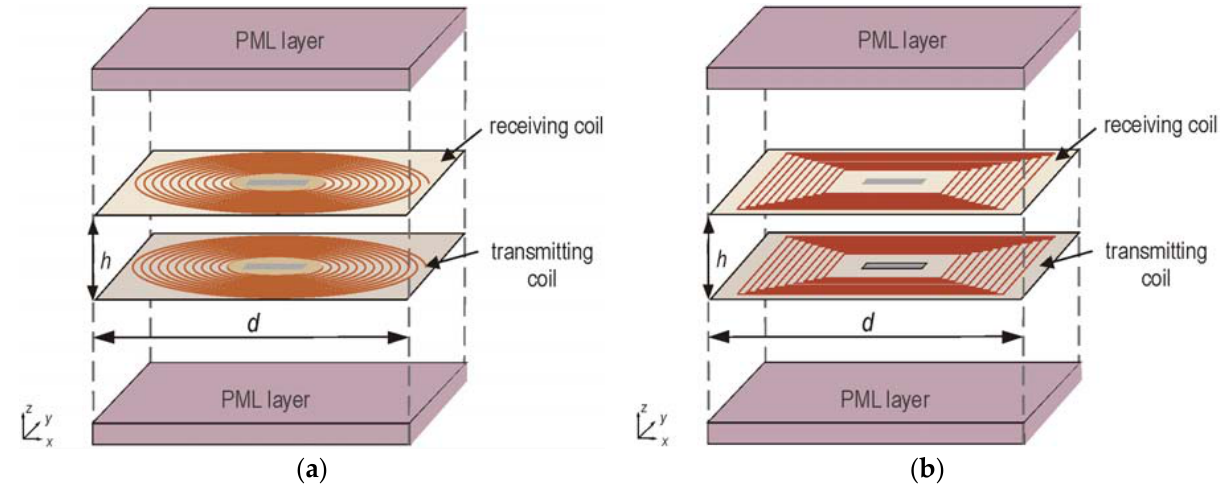
Figure 4. A numerical three-dimensional model of the WPT cell with the following: ( a ) circular coils, ( b ) square coils.